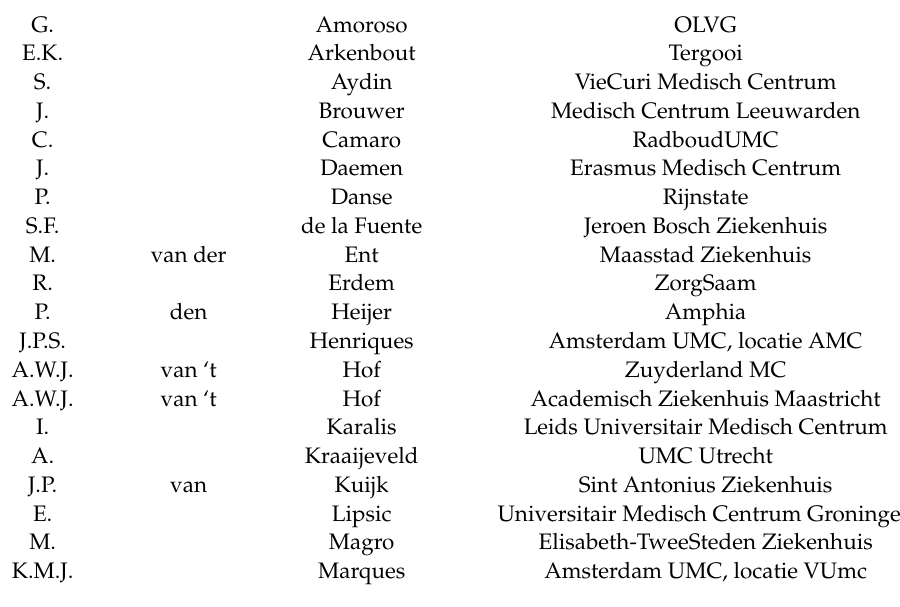
model, Figure S2: Kaplan–Meier curves per age category, Figure S3: Kaplan–Meier curves according to renal function, Figure S4: Kaplan–Meier curves for patients with and without OHCA, Table S1: Results of Cox regression analysis excluding patients who died before or at